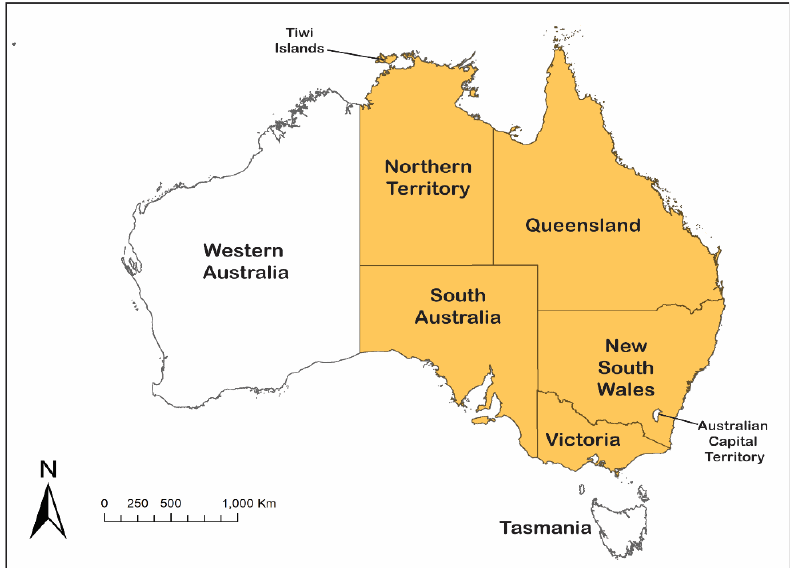
Figure 3. Map of Australia showing the Tiwi Islands and the States and Territories affected by JEV in 2021 – 2022 (orange shading). Human cases of Japanese encephalitis were reported from Northern Territory, Queensland, New South Wales, Victoria and South Australia; infected piggeries were reported from Queensland, New South Wales, Victoria and South Australia; infected feral pigs were reported from Queensland, South Australia and the Northern Territory; and isolations of JEV were obtained from mosquitoes trapped in Queensland, New South Wales and Victoria.